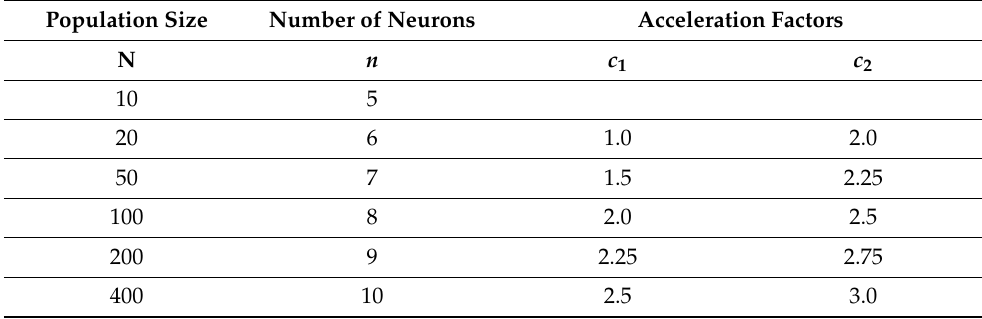
Table 4. Particle swarm optimization and artificial neural network parameter values. Population